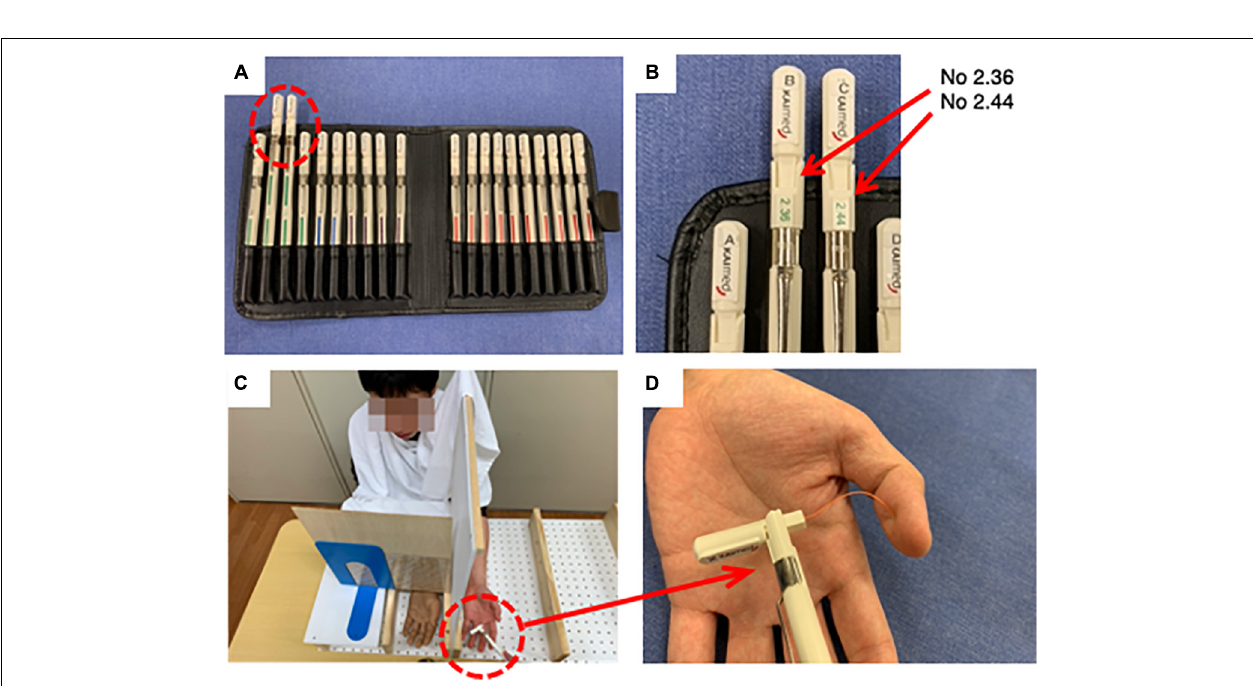
FIGURE 3 | Settings of the tactile evaluation. (A) The Semmes-Weinstein monofilament (SWMT, SOT-DM20A, Sakai Medical Co., Ltd., Japan). (B) Two types of filaments used in this experiment, No. 2.36 (0.02 g) and No. 2.44 (0.04 g). (C) Settings of the tactile evaluation. (D) Detection site in tactile evaluation.